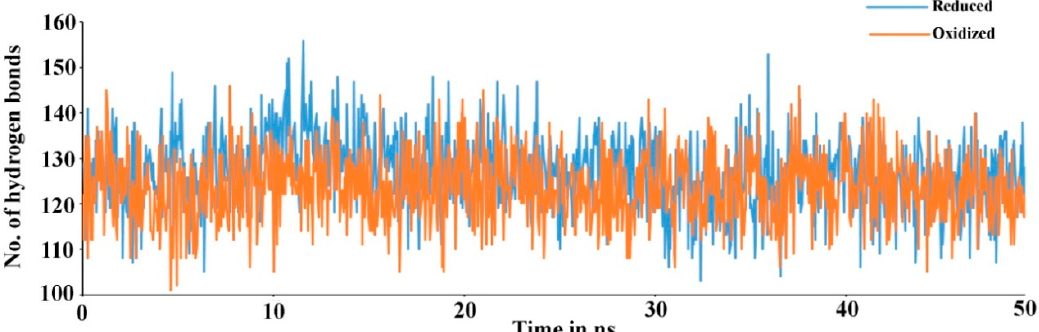
Figure 5. Total number of hydrogen bond found in reduced (blue) and hyperoxidized (orange) Prdx6 during the simulation period.